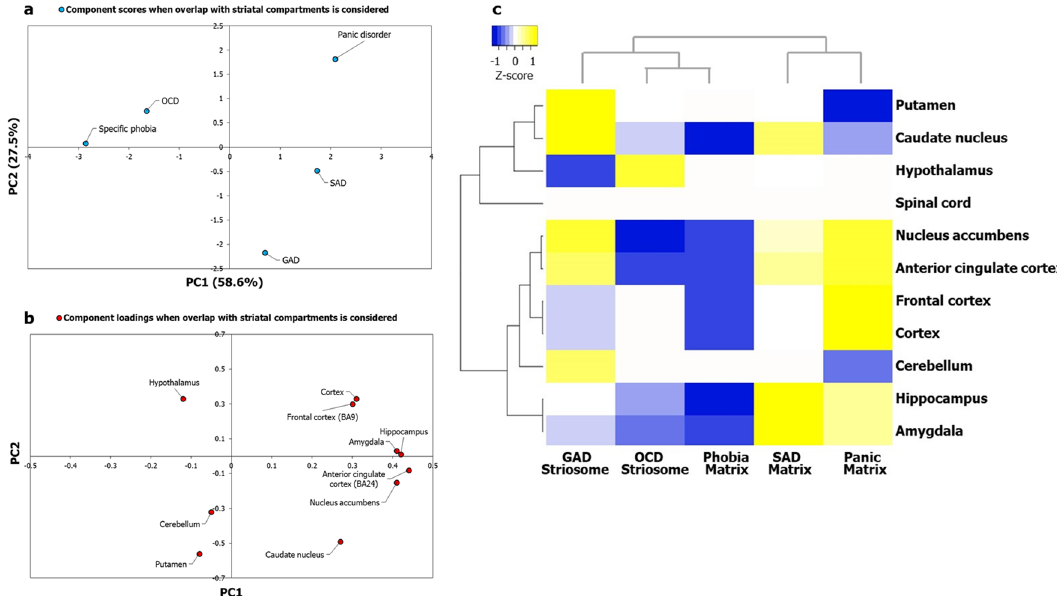
Figure 4. Principal component analysis and clustering analyses of AD-SMIs revealed uneven influence of key brain regions linked to anxiety etiology and distinct AD groups. ( a ) PCA was performed with the p values of enrichment of genes that co-occur in specific ADIs and SMIs. As observed in Fig. 5, specific ADIs share discrete and distinct statistically significant overlaps with either SI or MI, namely, GAD and striosome, OCD and striosome, phobia and matrix, SAD and matrix, and panic disorder and matrix. The enrichment of these genes among those exhibiting high/medium expression in 13 brain regions (TPM > 9) compiled from GTEx was checked. The statistical significance of region-wise enrichment was computed as p values. These values were transformed to − log 10 P values, which were then assembled into a data matrix containing brain regions as rows and ADs as columns (represented as a heatmap in Fig. ( c )). Unit variance scaling was applied across this matrix. Single value decomposition (SVD) with imputation was used to extract the principal components (PCs). Component scores of GAD-striosome, OCD-striosome, phobia-matrix, SAD-matrix and panic disorder- matrix (n = 5) corresponding to PC1 and PC2 explaining 58.6% and 27.5% of the total variance were plotted along X and Y axes respectively. ( b ) Component loadings of 10 dimensions, i.e. brain regions, contributing to PC1 and PC2 shown in ( a ) were plotted along X and Y axes respectively. In contrast with the pattern of component loadings of brain regions observed in Fig. 2b, PCA with genes shared between ADIs and SMIs appears to have captured uneven influences of several brain regions such as the ACC, amygdala, hippocampus, nucleus accumbens, putamen and caudate on the grouping patterns of ADs. ( c ) Variations in region-wise enrichment of genes (computed from GTEx data) shared between ADIs and SMIs are represented in the form of a heatmap. Specifically, normalized z-scores computed based on the –log 10 transformed p values, indicating the statistical significance of enrichment of GAD-striosome, OCD-striosome, phobia-matrix, SAD-matrix and panic disorder-matrix, are shown in the figure. Z-scores indicate relative enrichment of specific brain regions in the gene sets and are computed based on the number of standard deviations that separate a given p value from the mean. Clustering was performed using the hierarchical clustering method with average linkage. The dendrograms were derived from the clustering analysis based on computation of Pearson correlation coefficients between the data points. Two main clusters were detected among the ADs. SAD and panic formed one cluster. OCD and phobia formed a sub-cluster within the second main cluster. GAD was an outgroup to the sub-cluster of OCD and phobia. The clustered heatmap was created using Heatmapper (http:// www. heatm apper.